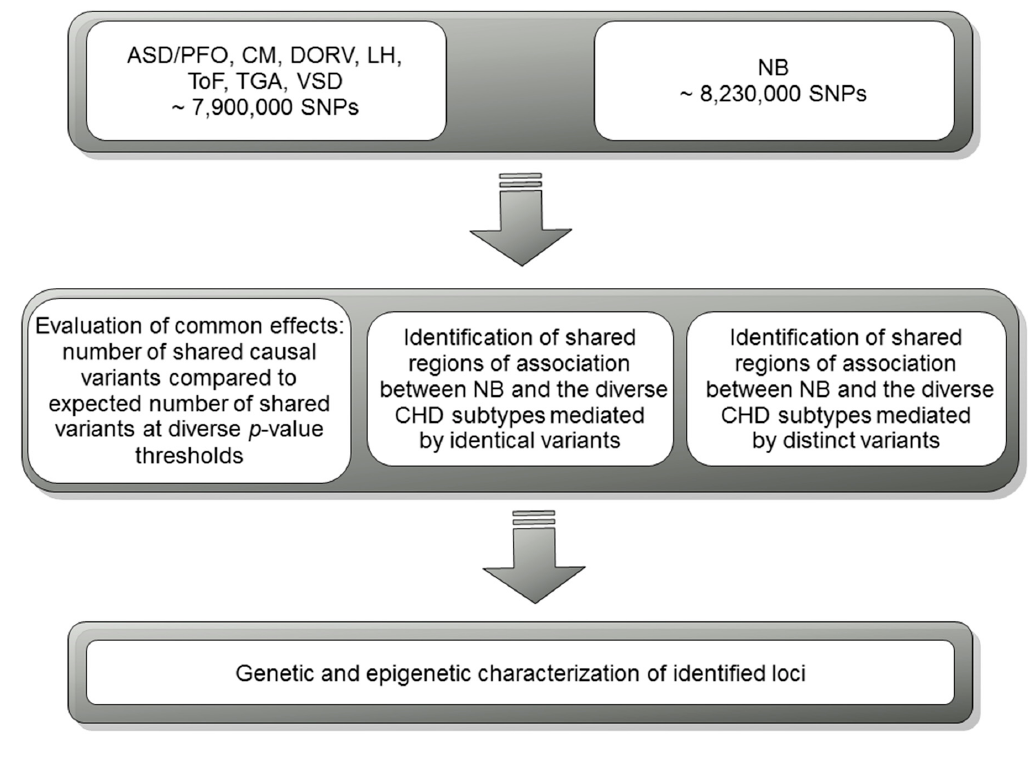
Figure 1. Study design and workflow.